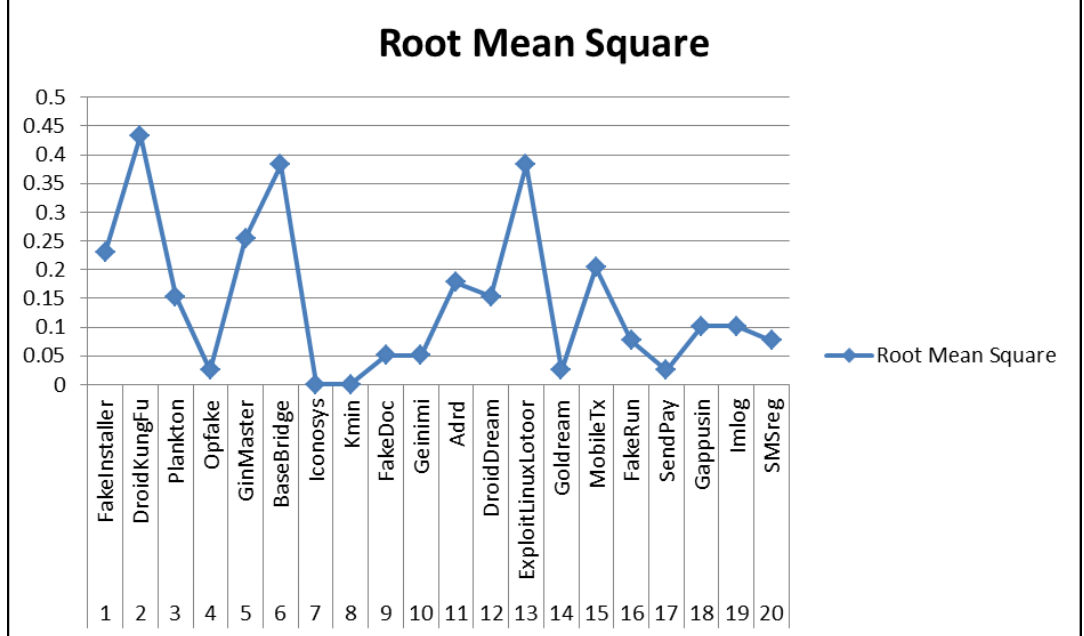
Figure 10. Root mean square analysis of top 20 malware families of Drebin